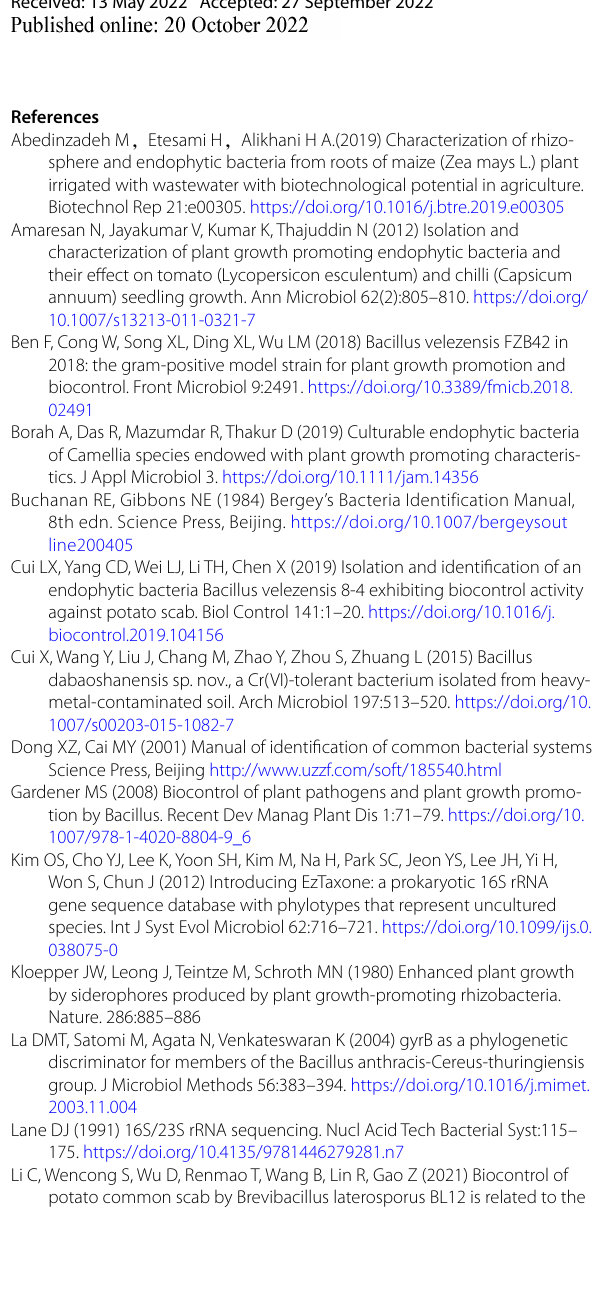
Data are mean standard errors. Different letters indicate significant differences according to the Duncan’s multiple range test ( P < 0.05). Increase in yield ± treatment area — yield of control area)/yield of control